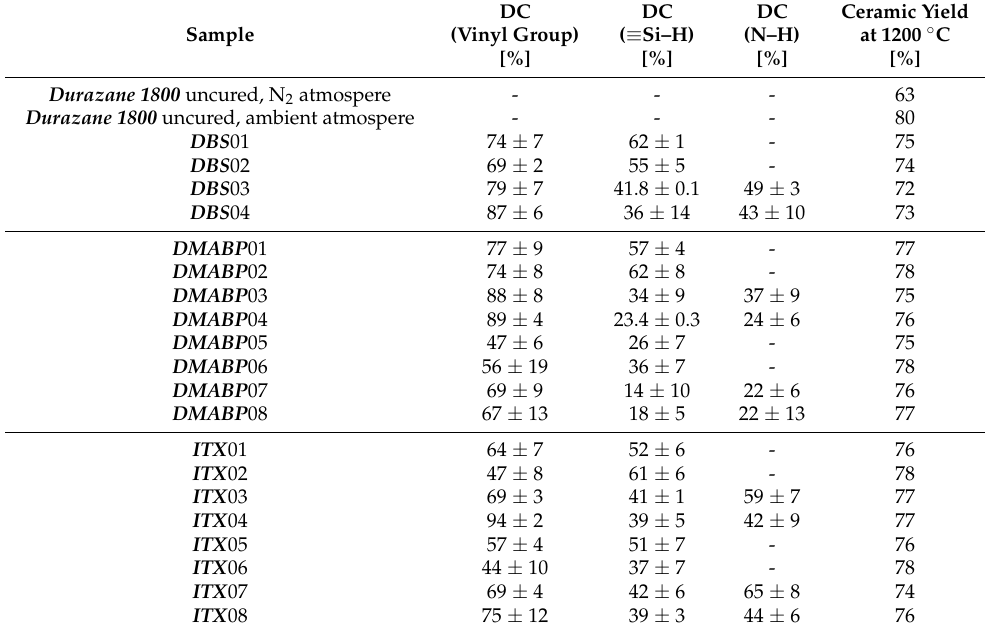
Table A1. Ceramic yield of the UV-cured samples measured from the residual mass of TGA at 1200 ◦ C. The degree of conversion (DC) of the reactive samples calculated by the absorption bands of the FTIR spectra.